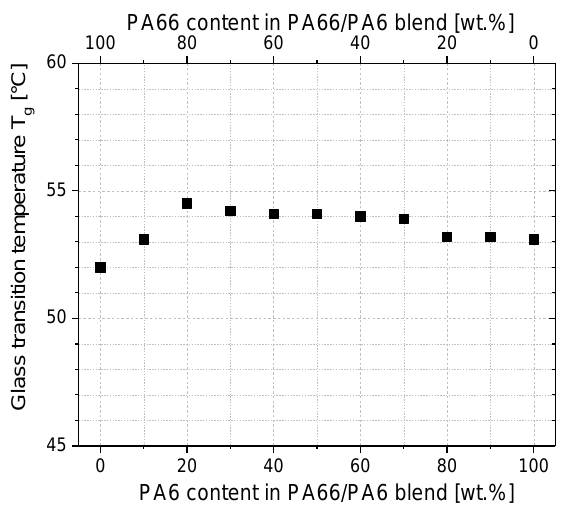
Figure 1. Glass transition temperatures with different PA6/PA66 blend compositions. PA = polyamide.